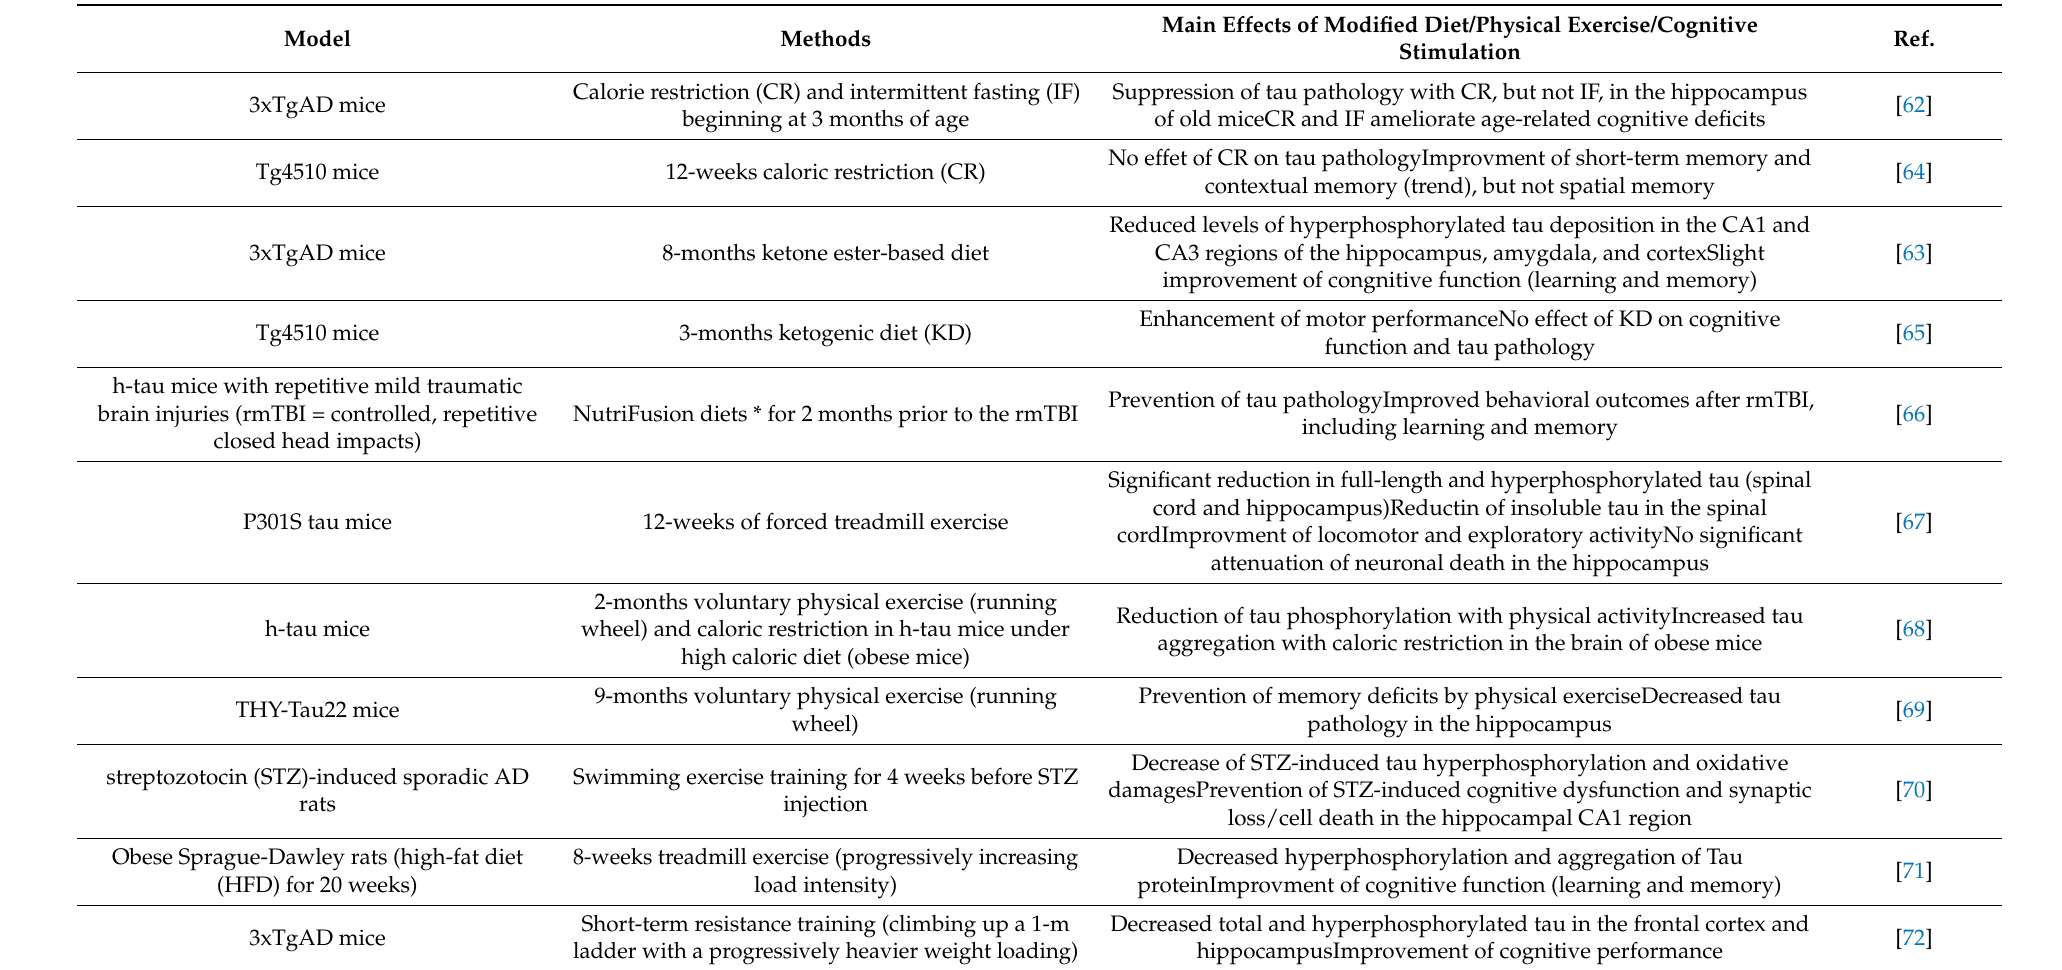
Table 1. Effects of modified diet, physical exercise and cognitive stimulation on tau pathology in animal